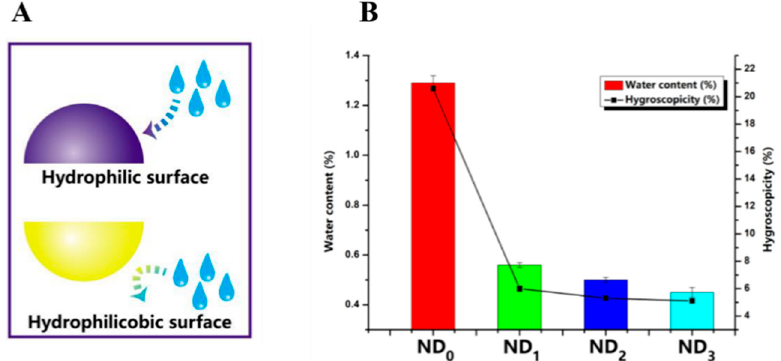
Figure 6. ( A ). Moisture absorption process of two di ff erent types of particles. The blue (above) surface is hydrophilic and thus sensitive to water absorption, whereas the yellow surface (below) is hydrophobic and protects the particle from ambient moisture. ( B ). Water content and hygroscopicity results of powder particles composed of di ff erent ratios of Netilmicin used as API and L-leucine. The mass ratio between Netilmicin and L-leucine for formulations ND0, ND1, ND2, and ND3 is, respectively, 100:1, 50:1, 30:1, and 10:1 ( n = 3). Reproduced from [43], which is licensed under a Creative Commons Attribution-(CC BY 4.0)